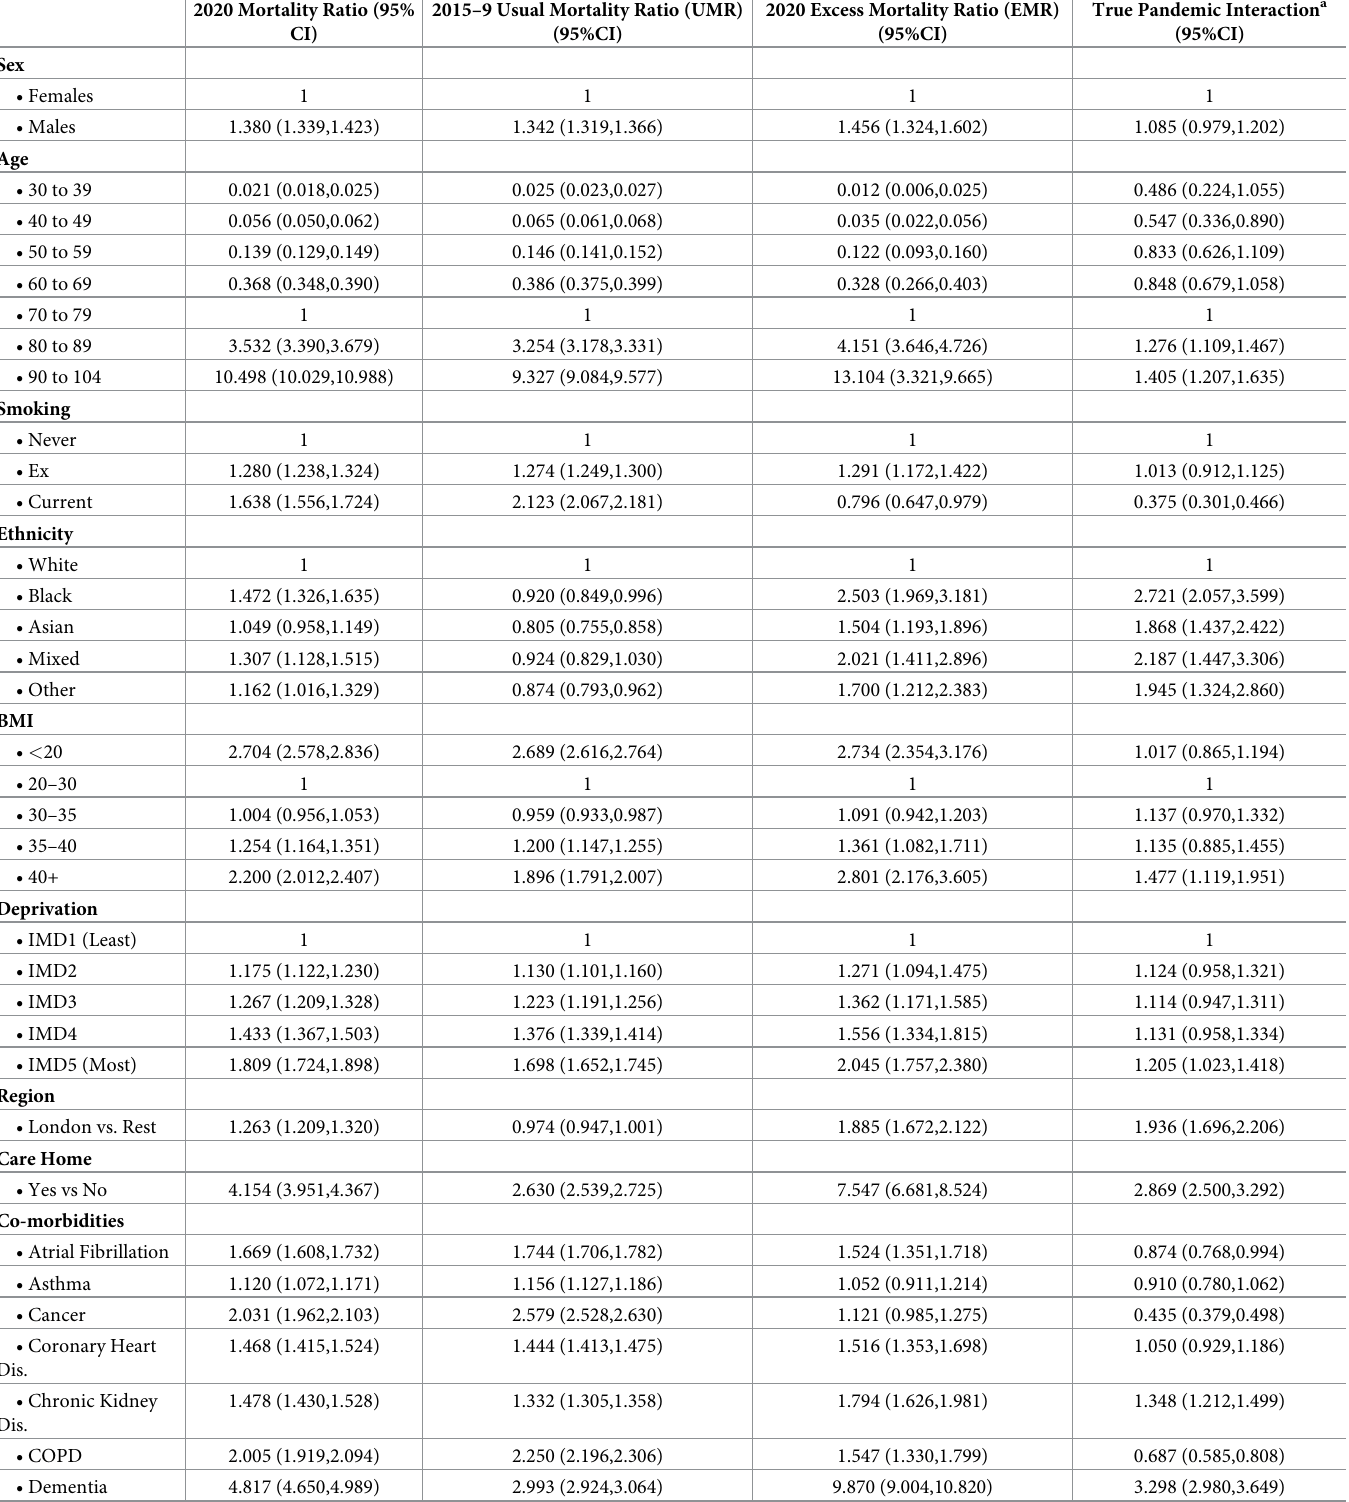
Table 2. Mortality ratios for 2020 and 2015–9 (Usual) with corresponding excess mortality ratio (EMR) and true pandemic interaction